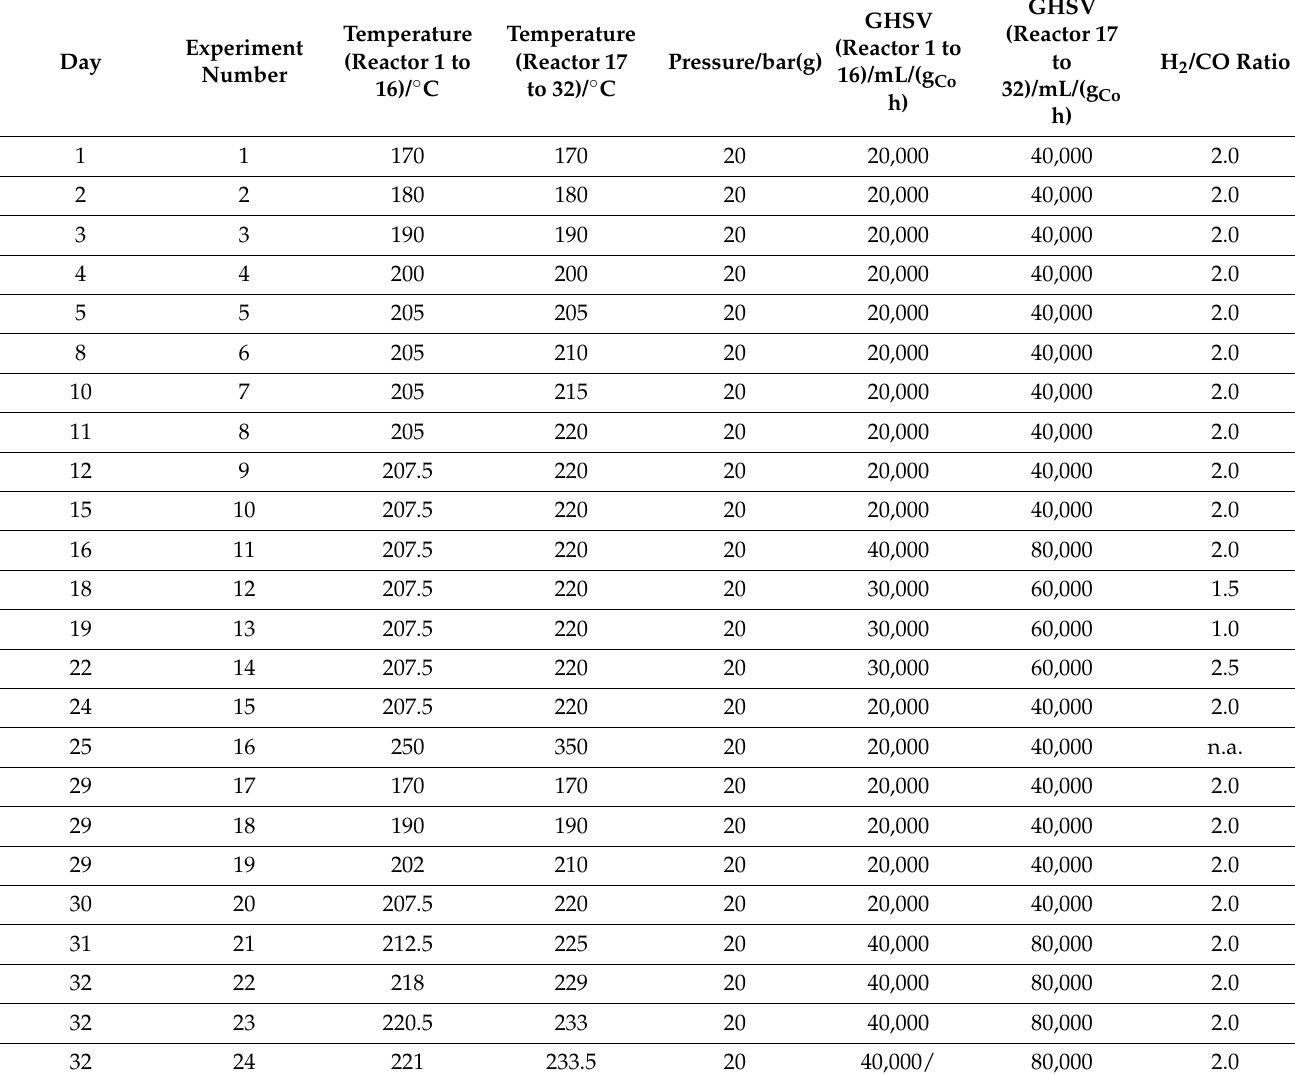
Table A1. Detailed overview of experimental